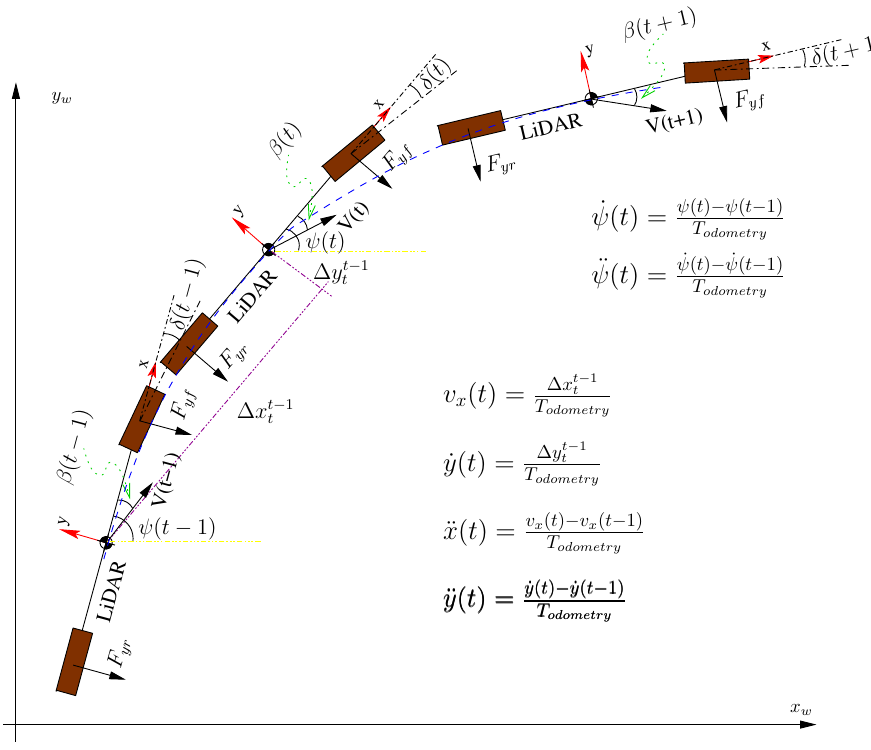
Figure 3. Evaluation of variables ¨ y , v x , ¨ ψ , ˙ ψ with LiDAR odometry.